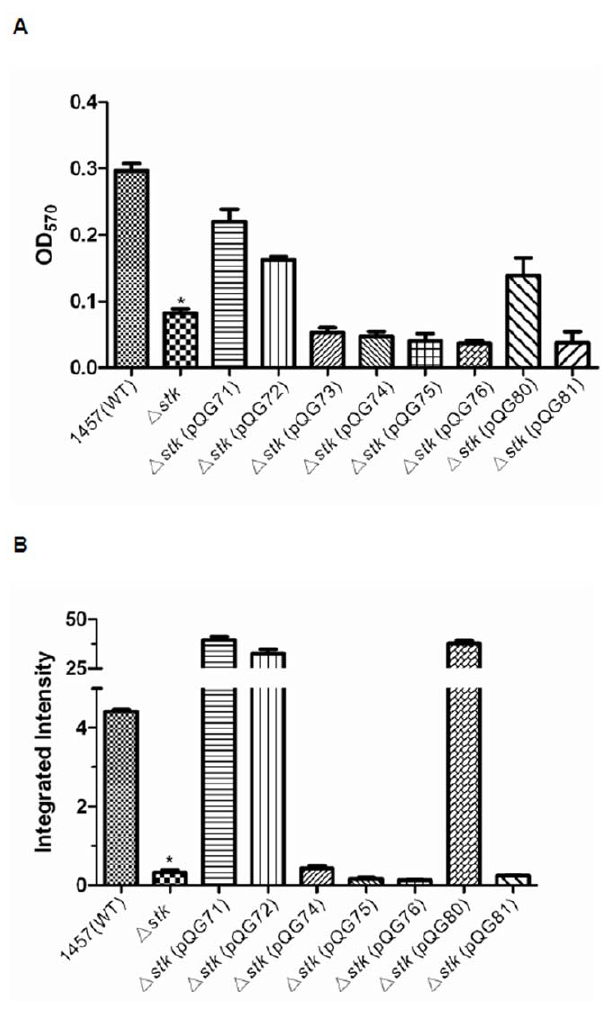
Figure 3. Stk influences primary attachment and PIA produc- tion in vitro . A. Influence of Stk and Stk domains on primary attachment. The stk mutant strain was complemented with plasmids expressing different domains of Stk: pQG71, full length; pQG72, kinase domain; pQG73, transmembrane domain; pQG74, PASTA repeated domain; pQG75, C-terminal domain; pQG76, kinase domain without ATP-binding site; pQG80, kinase domain with D133E mutation; pQG81, kinase domain with D126E mutation, and primary attachment was determined. Data were derived from three independent experiments, with 4 replicates in each experiment. *, P , 0.05 (versus WT). B. Influence of Stk and Stk domains on polysaccharide intercellular adhesin (PIA) production. PIA was determined in the same strains as in (A) using immunodot blots with anti-PIA serum and photodigital evaluation. Values represent the means 6 standard errors of the means from three independent experiments, *, P , 0.05 (versus WT).